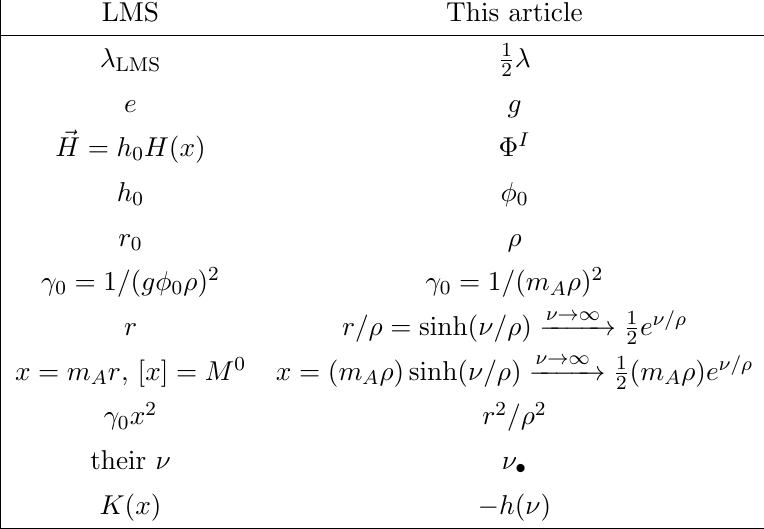
Table 2 . Translation dictionary of notation between the LMS papers and us. Both of us have k = (cid:3) = 3 < 0 and k = 1 =(cid:26) 2 = 1 =r 2 . Since we use (cid:23) for the radial distance from the defect 0 j j